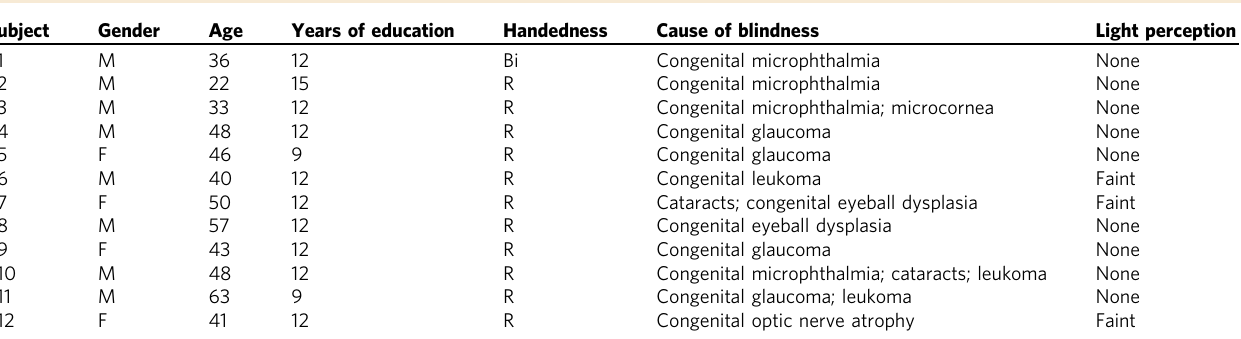
design. We computed an ANOVA model for a domain X imperceptibility X group effect in Experiment 1 (a block-design experiment) and looked for areas showing a group X impercept- ibility interaction, different responses based on perceptibility in the two groups, across concept domains. Among the brain regions showing preference for abstract concepts in both groups, only the left ATL also showed such an interaction, in two clusters NATURE COMMUNICATIONS| (2018) 9:5250